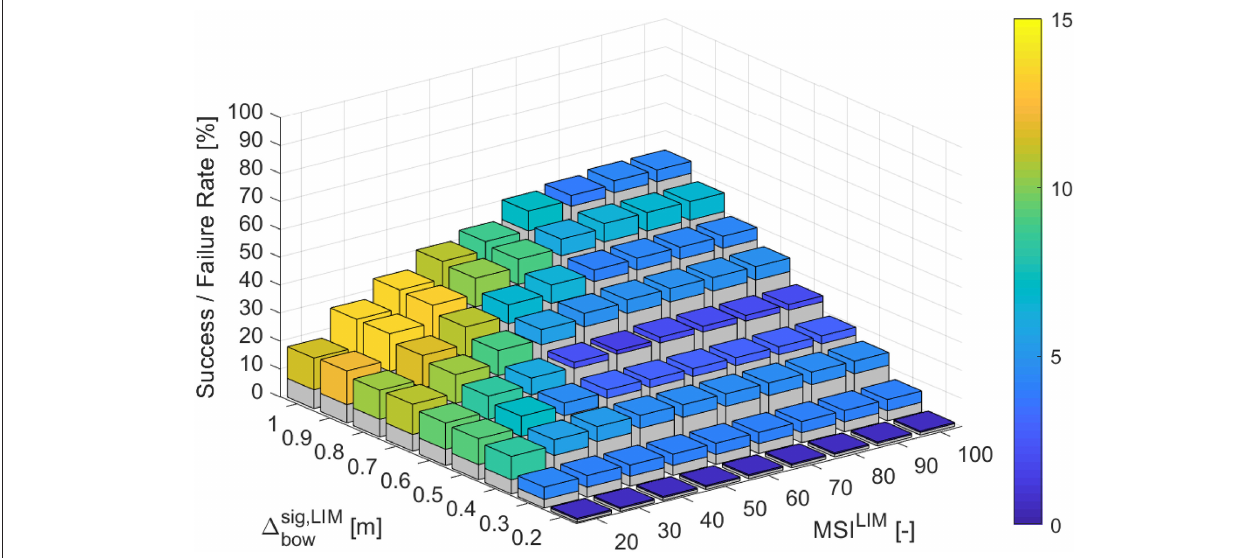
FIGURE 11 | Results of the analysis for the hindcast 1st October 2018–31st March 2019. The gray bars represent the percentage of trips that are successful according to both the tool and the traditional approach, for different combinations of MSI LIM and 1 sig,LIM bow . Assuming MSI and 1 sig bow to be the actual measures of workability, the colored bars represent the combined percentage of “false positive” and “false negative” trips. In those trips, the traditional approach failed the correct prediction, either assessing the O&M task feasible when it was not (“false positive”) or vice versa (“false negative”).